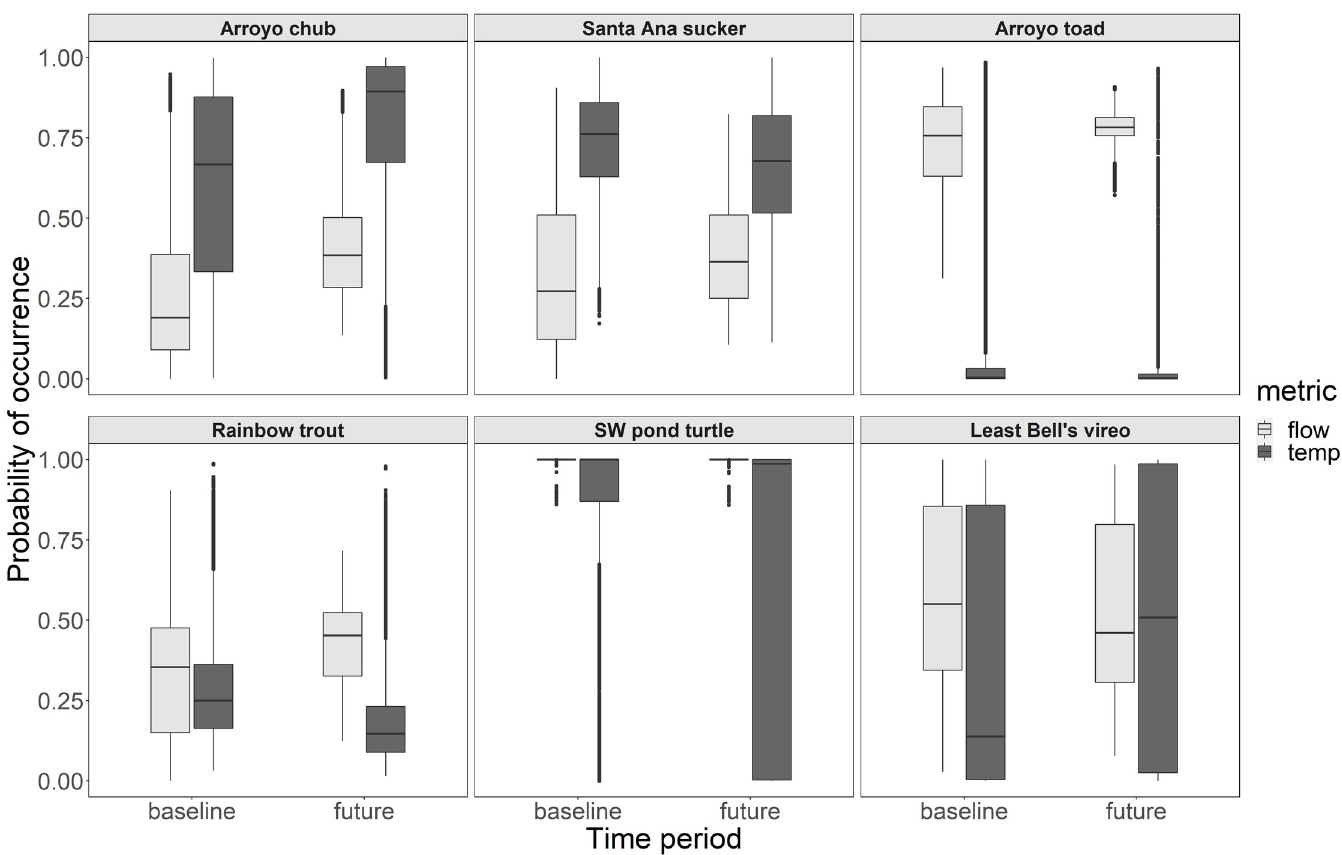
Fig 5. The distribution of probability of occurrence for the regional stream reaches due to streamflow (light grey) and stream temperature (dark grey) in the baseline and end-of-century time period (future). In each time period, the lower distribution could be considered the variable that is limiting habitat suitability for each species. Boxplots show the 25 th and 75 th percentiles, and 1.5 � the inter-quartile range at the upper and lower end. Points beyond the ‘whiskers’ represent outliers.